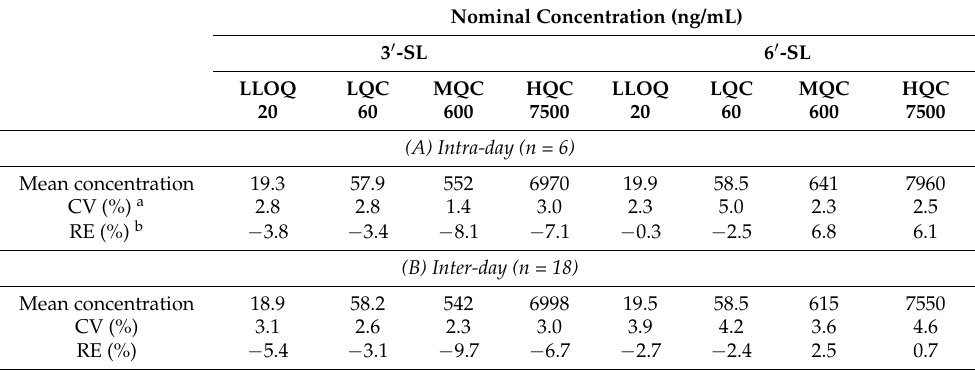
Table 2. Accuracy and precision for intra-day and inter-day.